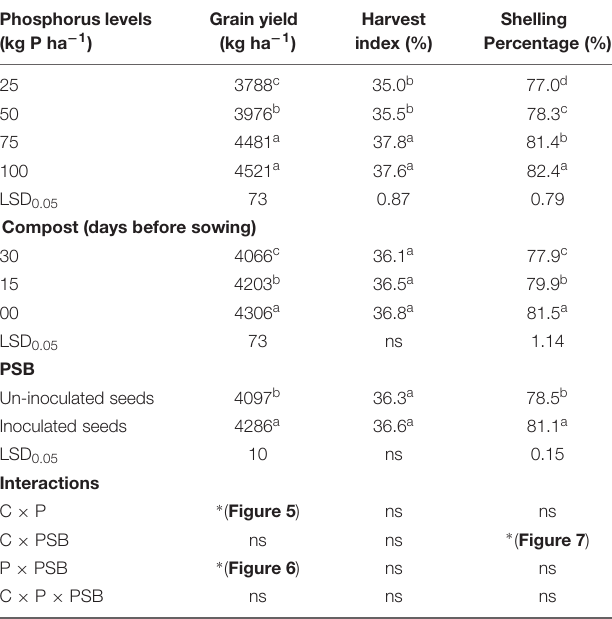
TABLE 2 | Grain yield, harvest index and shelling percentage of maize as affected by affected by phosphorus levels (P), compost application time (C) and phosphate solubilizing bacteria (PSB).